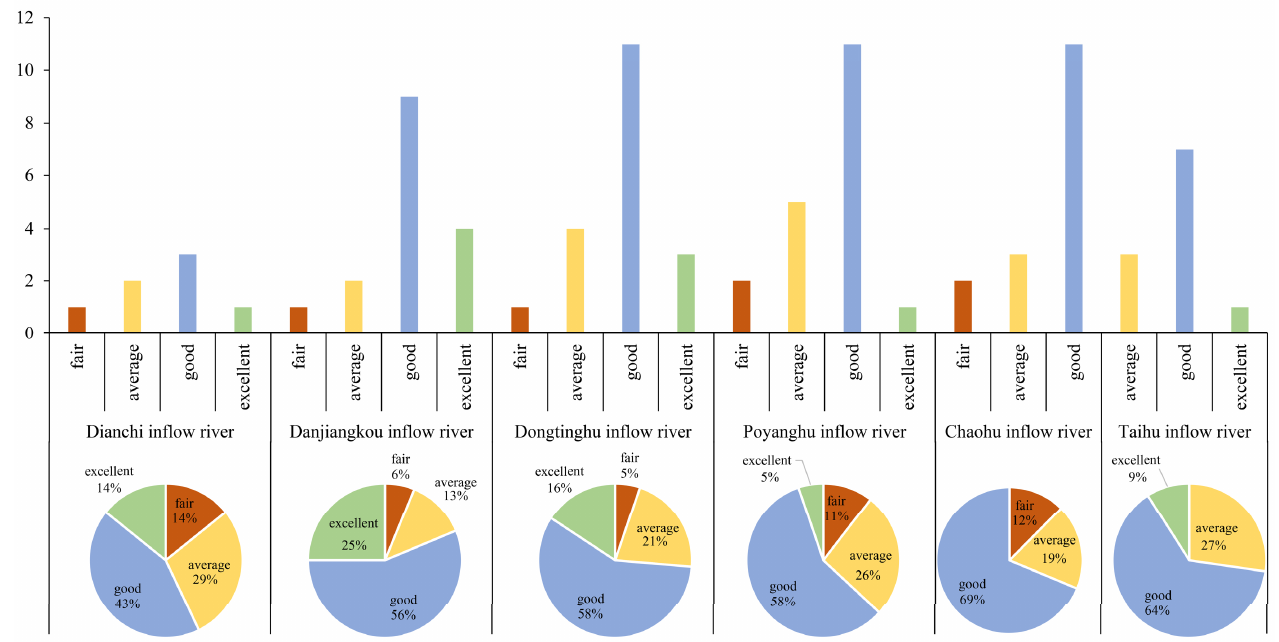
Figure 8. The ecosystem health assessment of each inflow rivers based on random forest